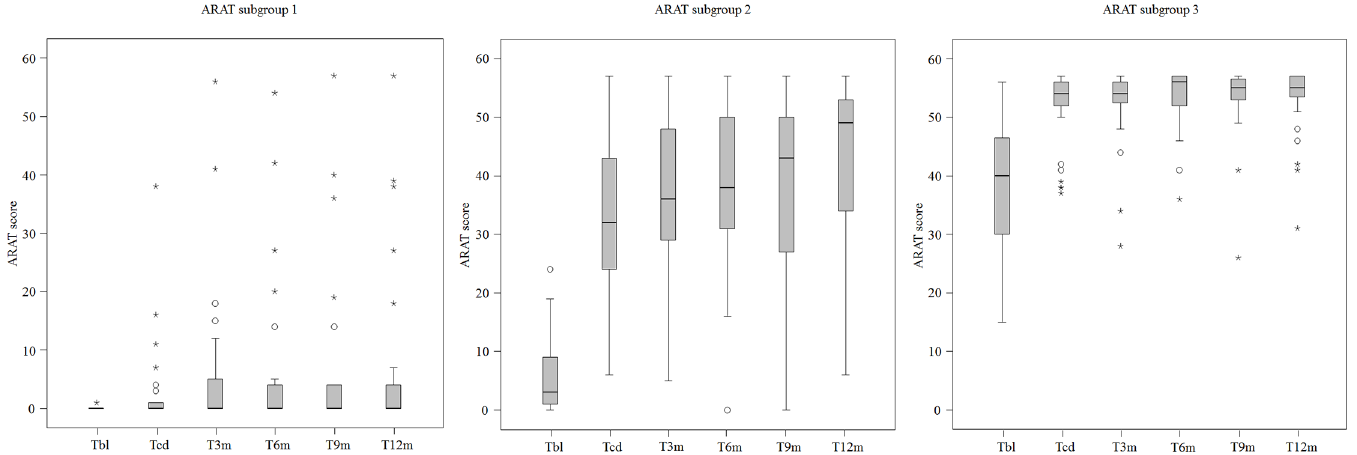
Fig 4. Boxplots of the ARAT data per measurement moment for each of the three groups. ARAT = Action ResearchArm Test; T BL = Baseline; T CD = ClinicalDischarge; T 3m = (= T CD + 3 months); T 6m (= T CD + 6 months); T 9m (= T CD + 9 months);T 12m (= T CD + 12 months). Circles = outlier value; Asterisk = far out value.